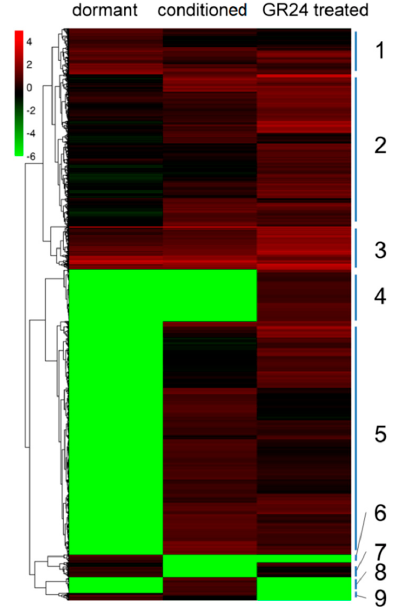
Figure 6. Heat map from hierarchical clustering of differentially expressed genes during P. aegyptiaca seed germination. Expression changes and cluster analysis of 5324 genes that were differentially expressed between any two of the three samples. Each row represents a differentially expressed gene (DEG), whereas each column represents a sample. Changes in expression levels are shown in color scales with saturation at >2.0-fold changes. Green and red color gradients indicate a decrease and increase in transcript abundance, respectively.